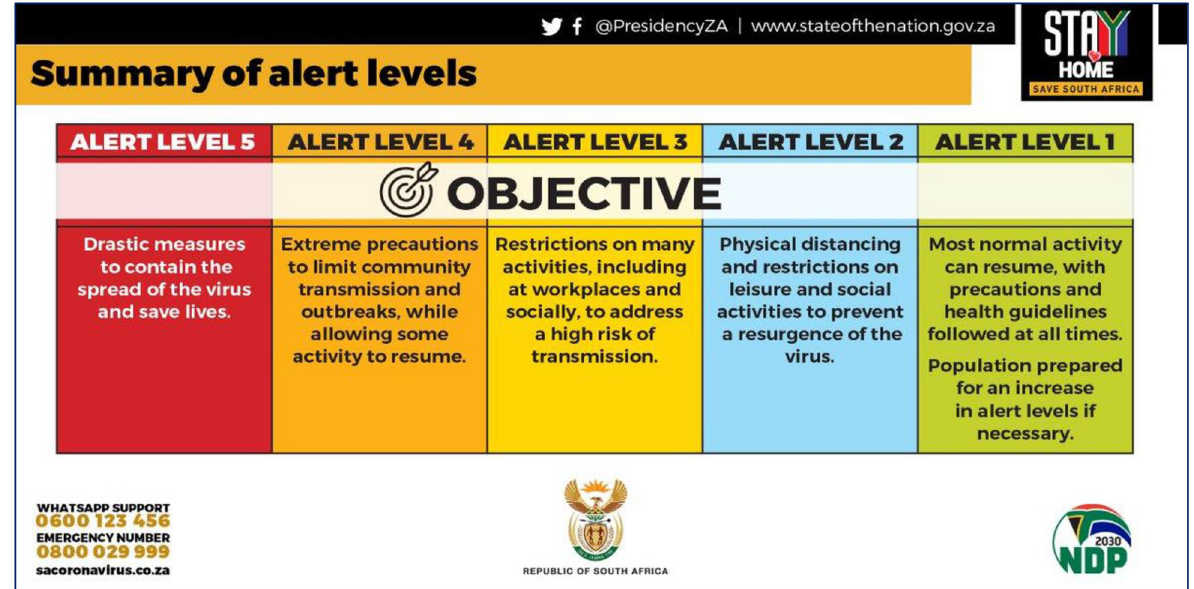
Fig 1. Summary of alert levels during South Africa’s COVID-19 lockdown (Source: Official twitter page of the presidency of South Africa).